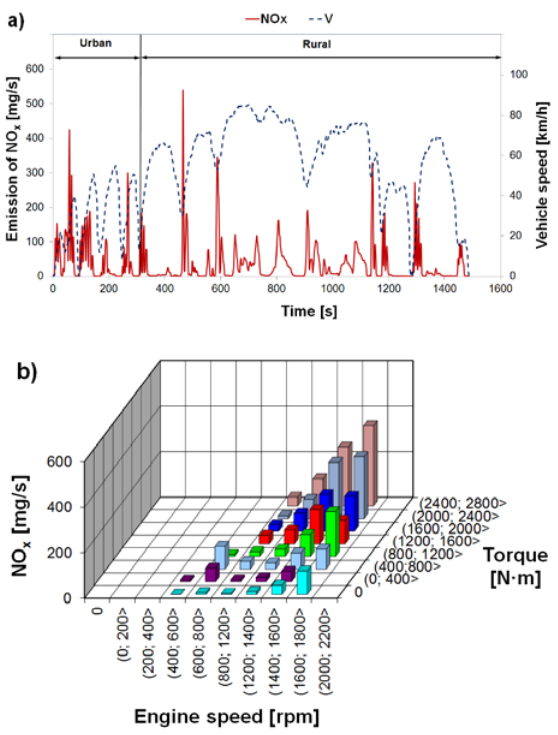
Fig. 7. The emission intensity of NO x with vehicle speed (a) and emission intensity in engine speed and load intervals (b)